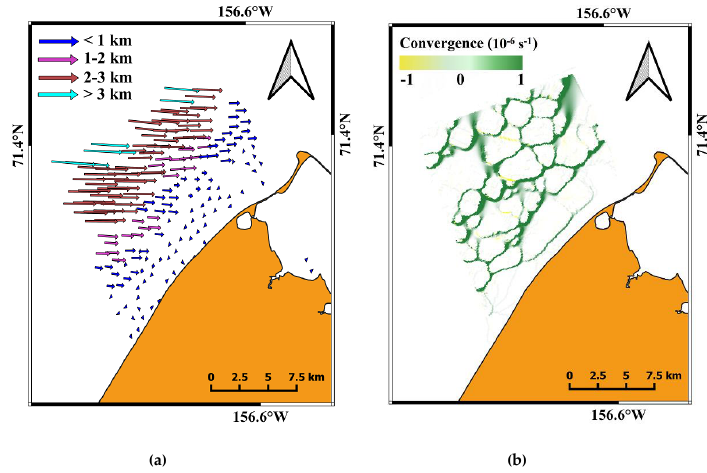
Figure 6. ( a ) SAR-derived ice drift vectors (only every 20th vector shown) and ( b ) convergence during 13–24 Jan 2012. Land is displayed in